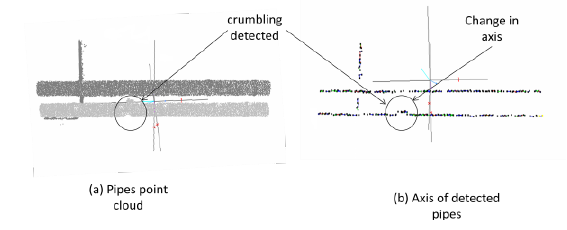
Figure 12. Deformation detection (a) Pipe containing a deformation and (b) Centres deviating where there